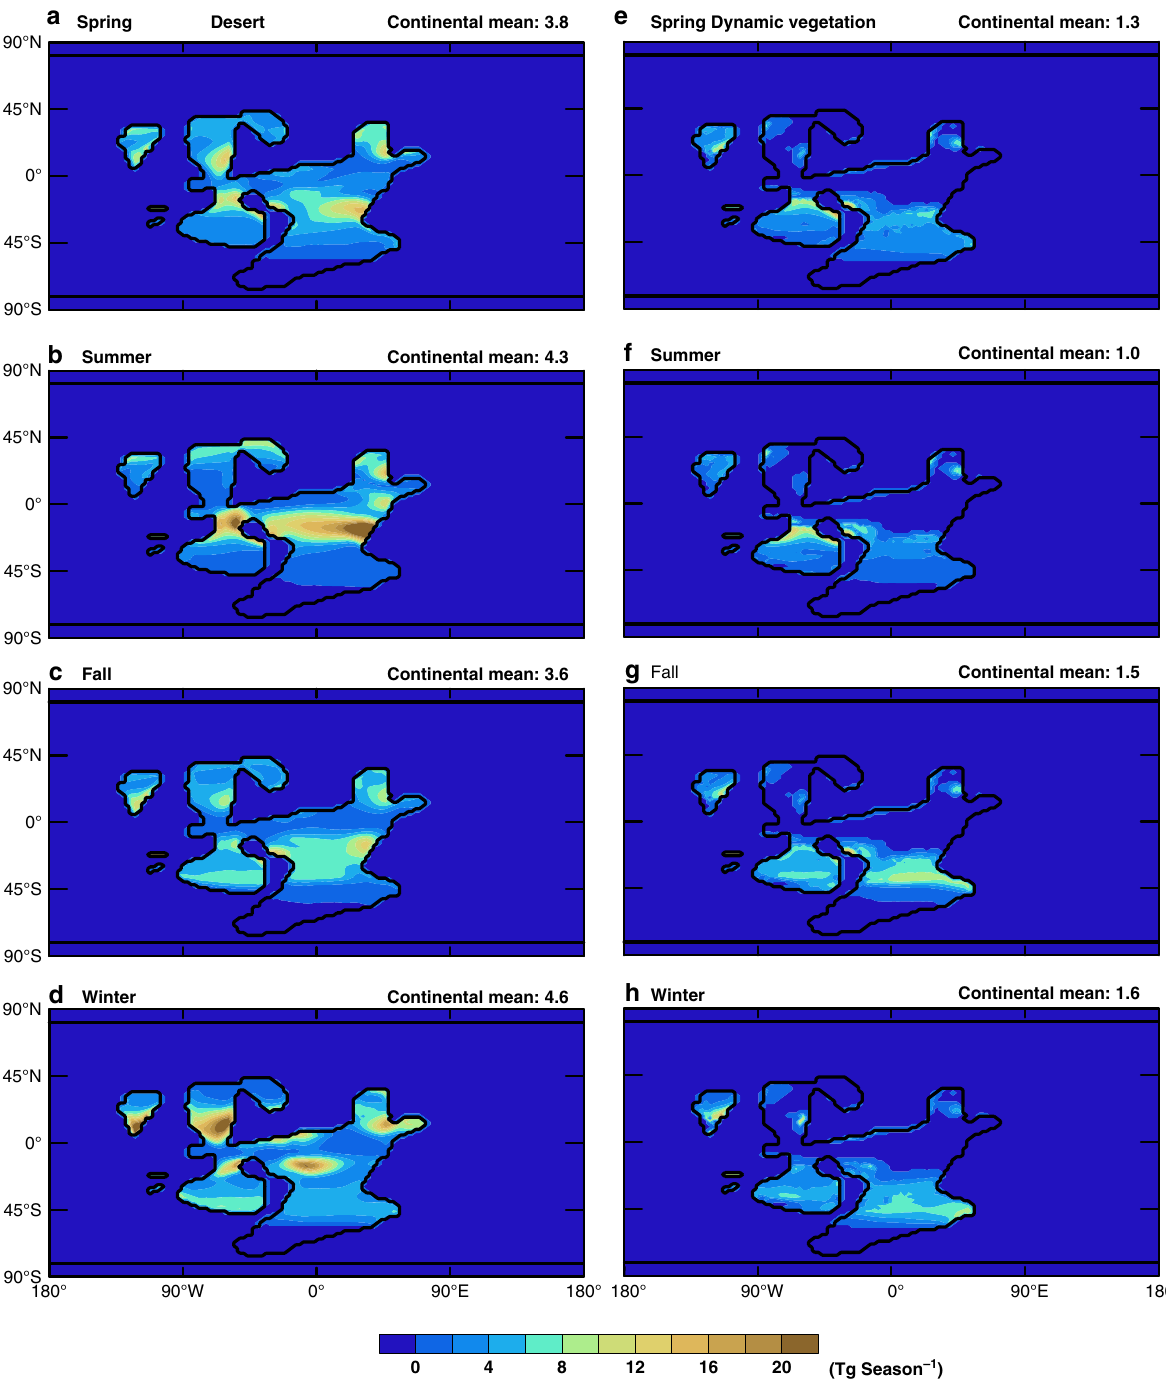
Fig. 1 Seasonal dust emission simulated by the model. Dust emission for four seasons when ( a – d ) vegetation is prescribed to be absent on land and ( e – h ) vegetation is simulated by the model. The surface erodibility is spatially and temporally uniform with a value of 0.0375. Each season has three consecutive months and the Spring starts from March. Black contour lines represent continental boundaries. Values on the upper right corner of each panel are the average of dust emission over the continents. Unit: Tg season − 1